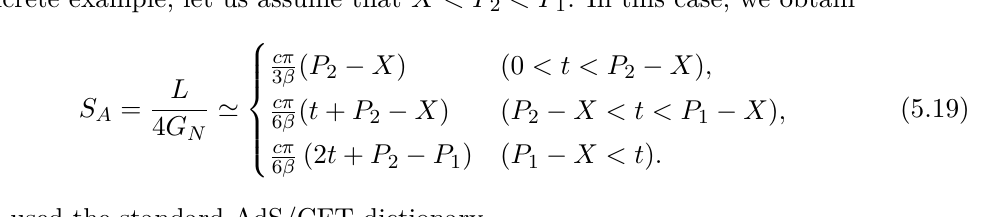
= 14 , P = 2 and 1 2 log(2 r ) . ∞ /r + 2